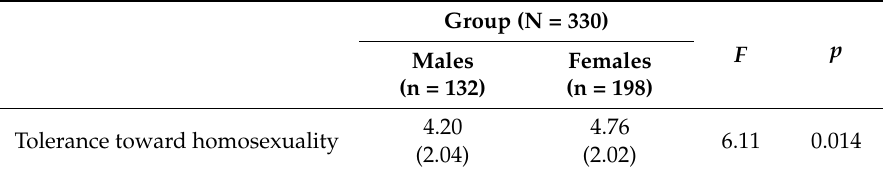
Table 5. ANOVA Results: Effect of Gender on Tolerance toward